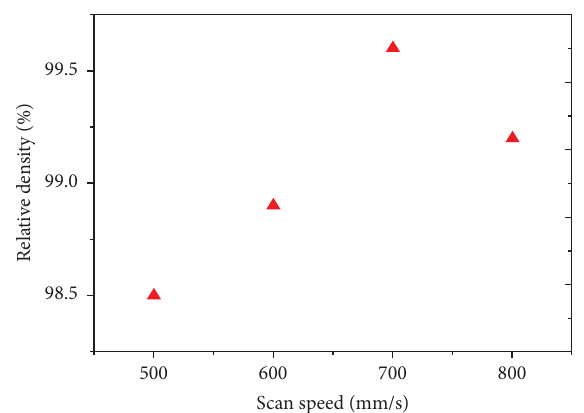
Figure 7: Relation between the relative density and scanning speed.